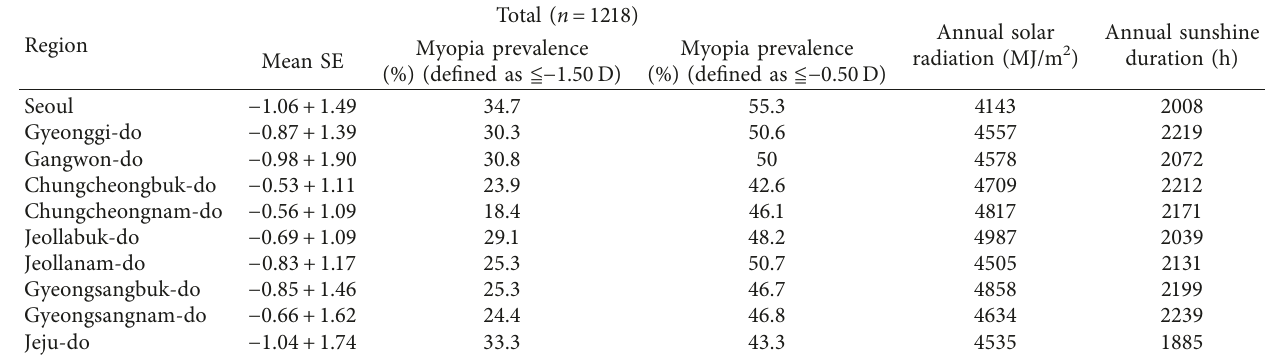
Table 1: Baseline characteristics of the study participants.